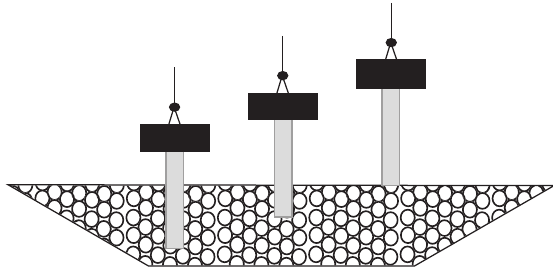
Figure 23: Schematic diagram of the density of alternative materials by piling and vibrating operation.